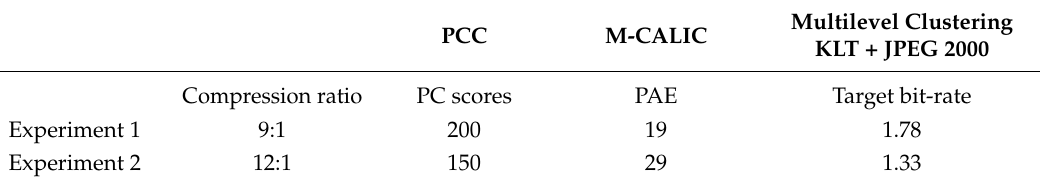
Table 11. Compression setting for PCC, M-CALIC, and Multilevel Clustering + JPEG 2000 comparison.